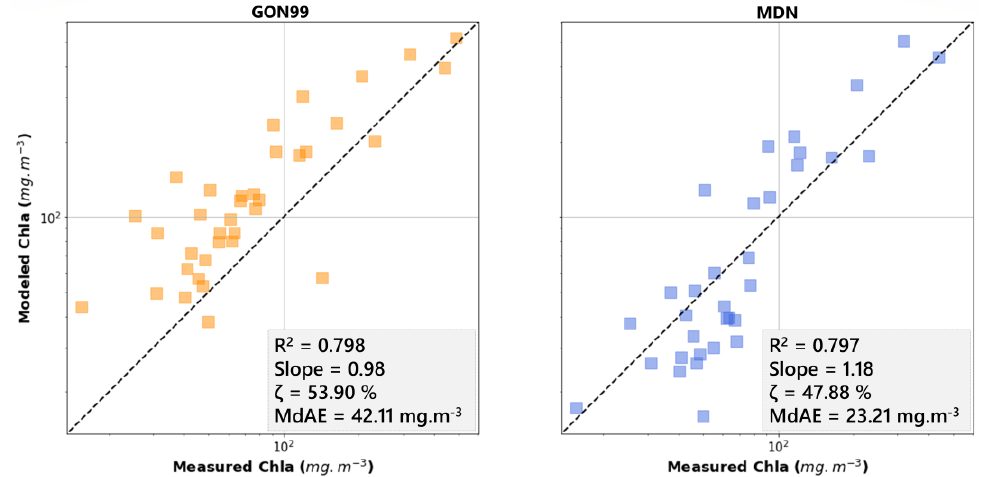
Figure 7. Performance assessment of semi-analytical (Gons [58]) and machine learning algorithms (MDN) using in situ measured Chl-a for 3rd – 10th, October, 2021. Reported metrics are median symmetric accuracy (ζ), slope, regression coefficient (R 2 ), and the median absolute error (MdAE).